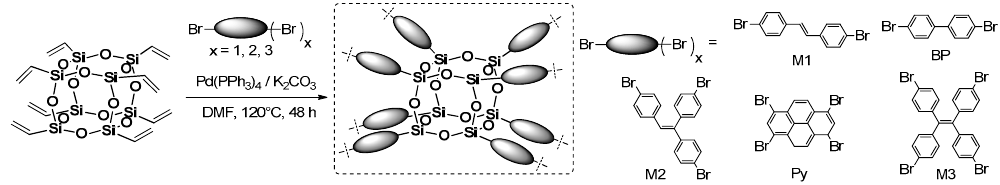
Figure 10. Synthetic route leading to hyperbranched 3D POSS-based materials obtained via Heck